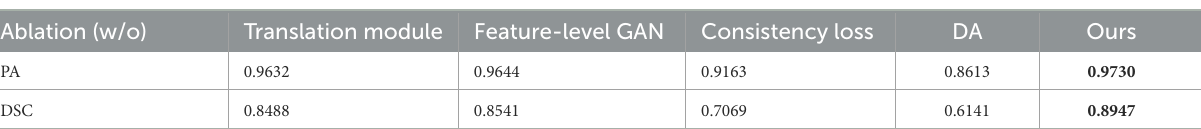
TABLE 8 Ablation study on various